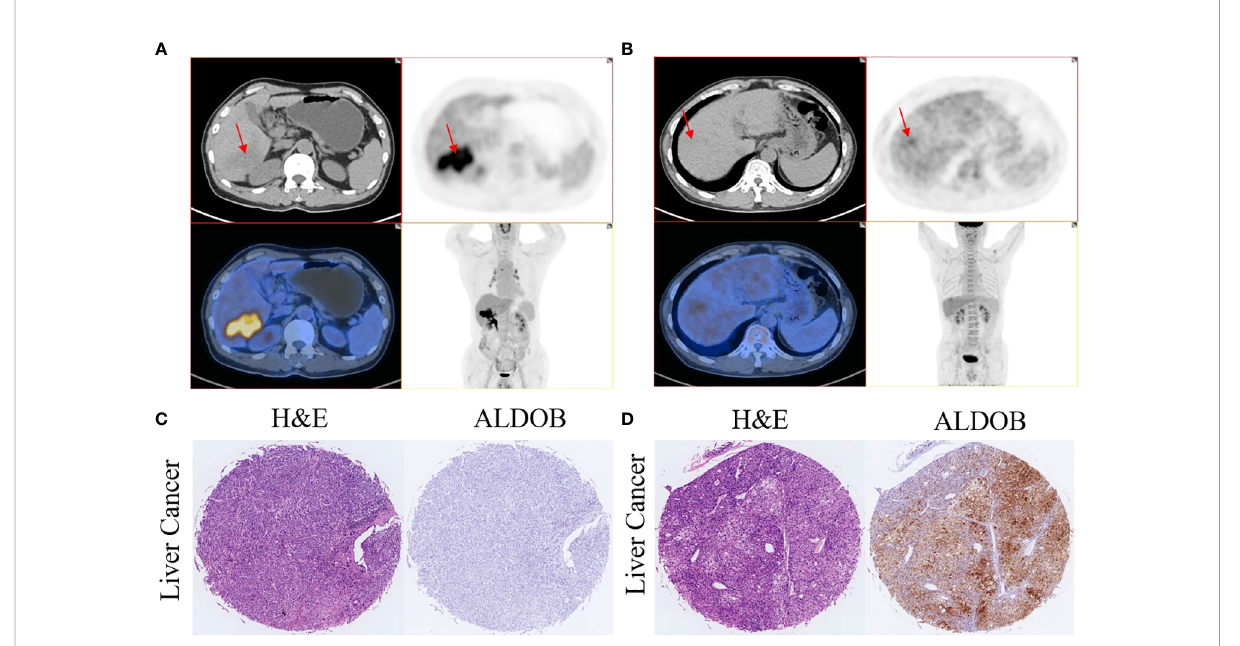
FIGURE 3 Representative images of 18F-FDG uptake and immunohistochemical staining of ALDOB in patients with HCC. (A, C) A 65-year-old male patient had HCC with negative ALDOB staining. 18F-FDG PET/CT scan revealed strong accumulation of 18F-FDG accumulation in the tumor lesion (SUVmax=12.5). (B, D) A 64-year-old male patient had HCC with positive ALDOB staining. 18F-FDG PET/CT scan did not show abnormal uptake of 18F-FDG in the tumor lesion